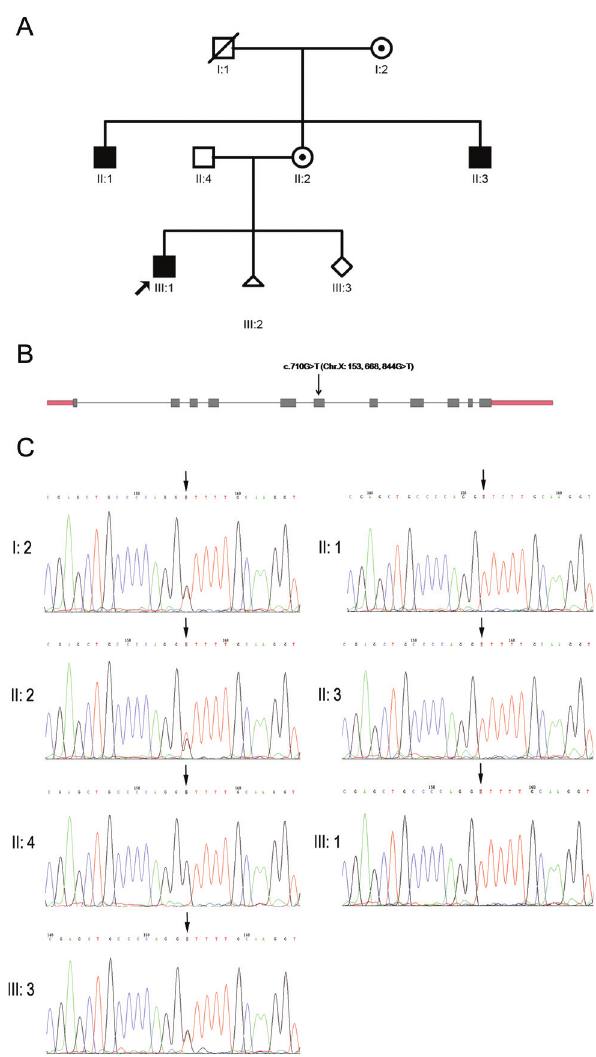
Figure 1 - Pedigree and mutation. (A) Pedigree of the SZMRX Family. (B) Schematic of GDI1 gene; arrow shows the c.710G > T mutation lo- cated at exon 6 of the GDI1 gene (chr X: 153,668,844). C. The c.710G > T mutation segregating with the phenotype of non-syndromic X-linked in- tellectual disability (NS-XLID) in all male patients (II:1, II:3 and III:1) was validated by Sanger sequencing; arrow shows the locationof c.710 (chr X: